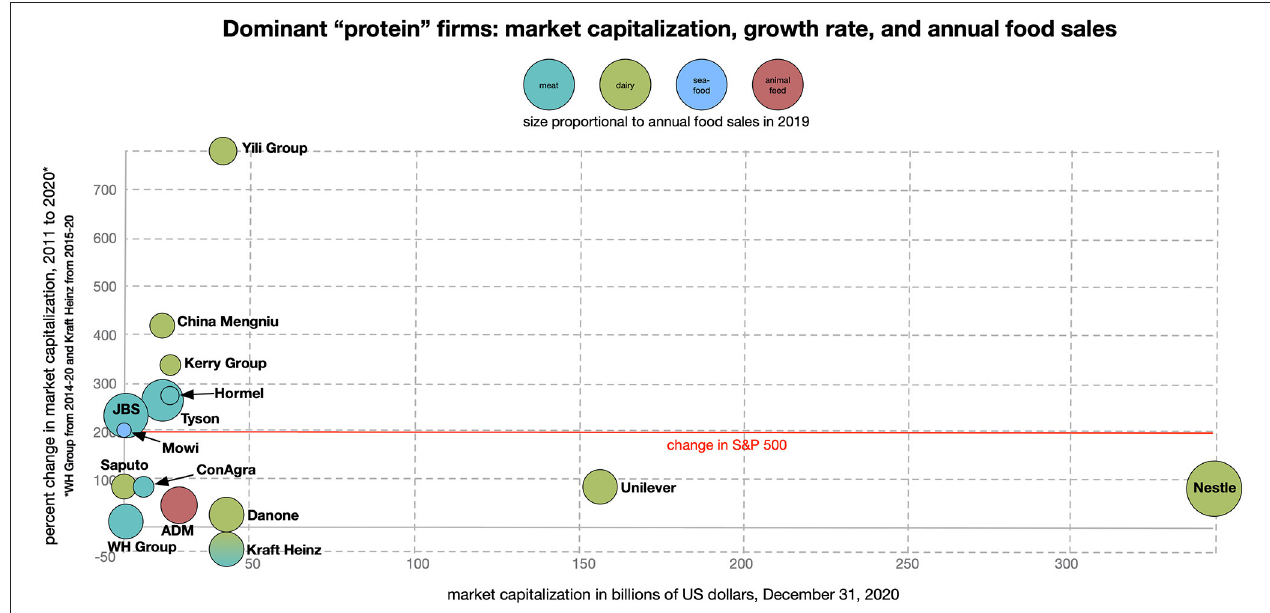
FIGURE 3 | Multi-variable plot of dominant publicly traded “protein” firms: market capitalization, growth rate relative to the S&P 500 from 2011 to 2020, and annual food sales in